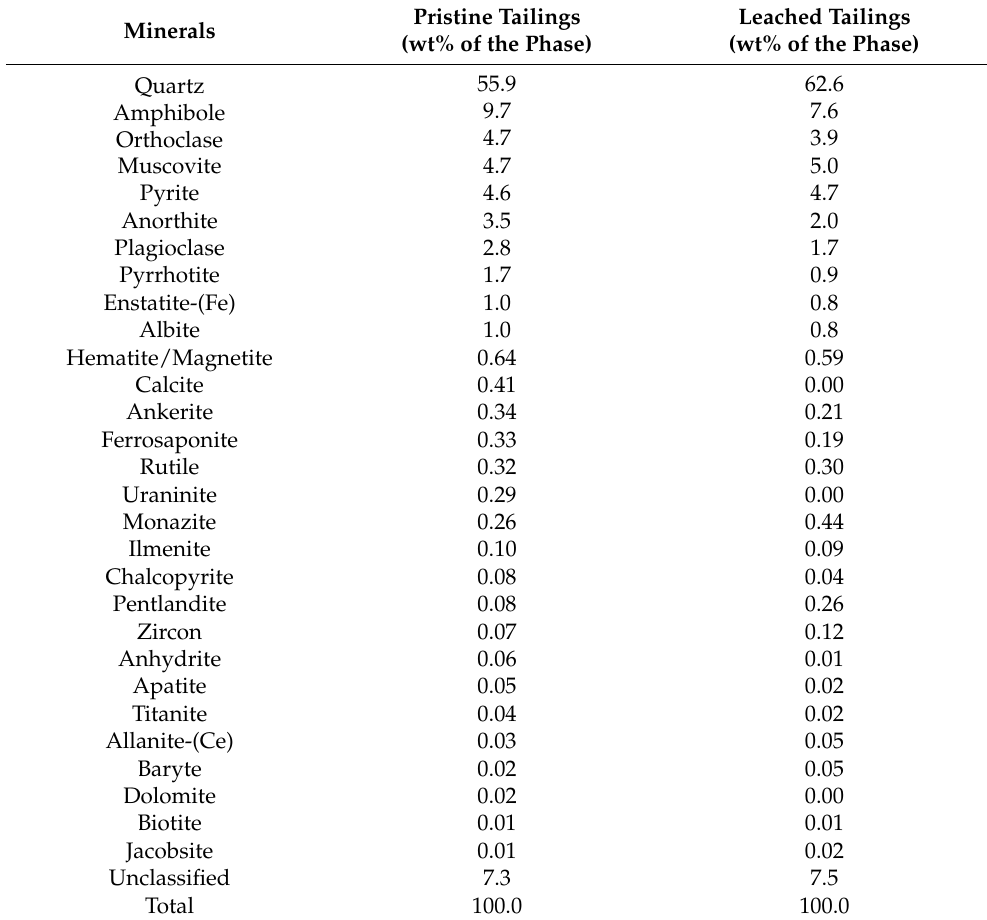
Table 6. Mineral phases quantified pre and post experiment by TESCAN Integrated Mineral Analyzer (TIMA)